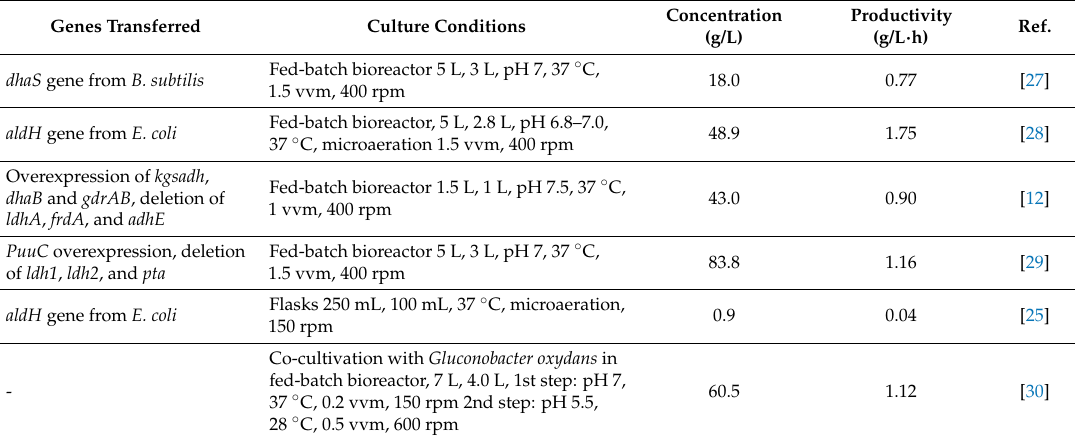
Table 1. Results of 3HP production from glycerol using K.